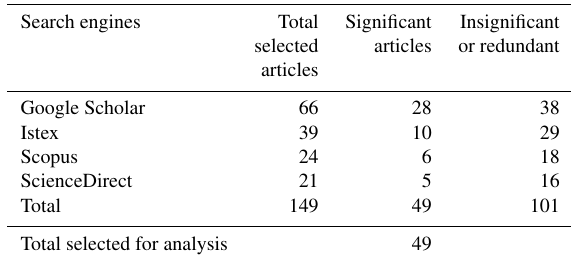
Table A2. Selected articles for the